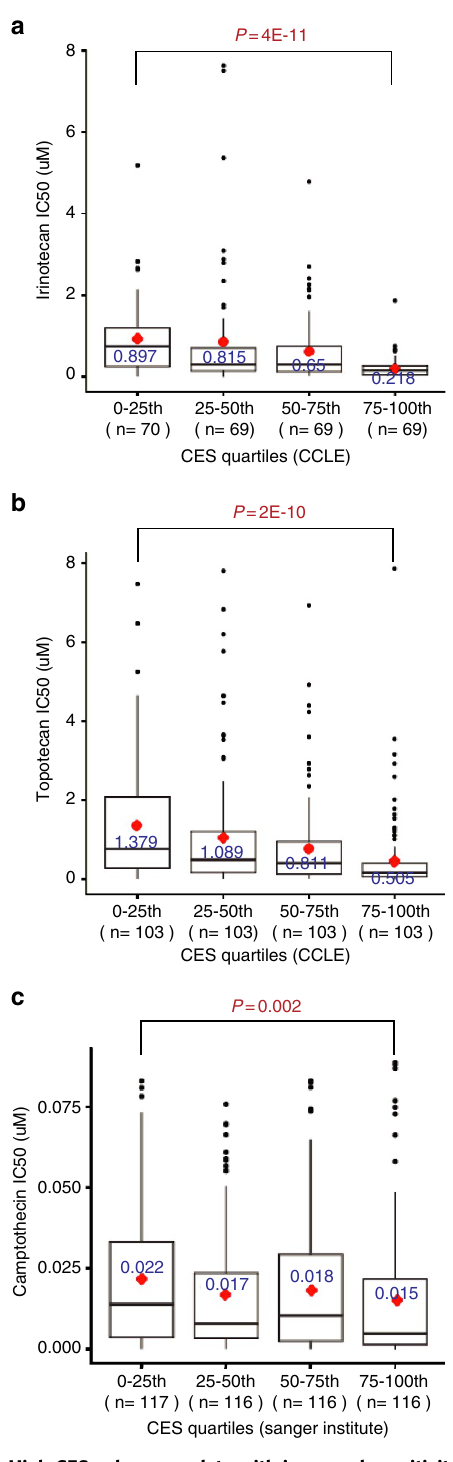
Figure 6 | High CES values correlate with increased sensitivity to Topoisomerase I inhibitors in cancer cell lines. Box plots of IC 50 s for Topo I inhibitors in cancer cell lines grouped by CES quartiles. Cell lines in the top CES quartile (75–100th) are significantly more sensitive to Topo I inhibitors than those in the bottom CES quartile (0–25th) determined by Wilcoxon rank-sum tests. Significant P values are indicated in red. ( a ) Irinotecan in CCLE data set. ( b ) Topotecan in CCLE data set. ( c ) Camptothecin in Wellcome Trust Sanger Institute CGP data